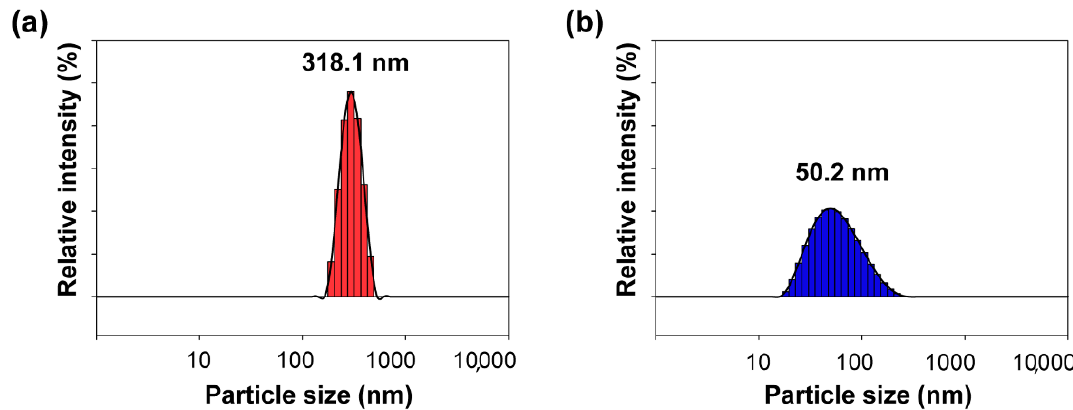
Figure 4. Particle size distributions of ( a ) ROIN-Si and ( b ) ROIN-Al nanoparticles.